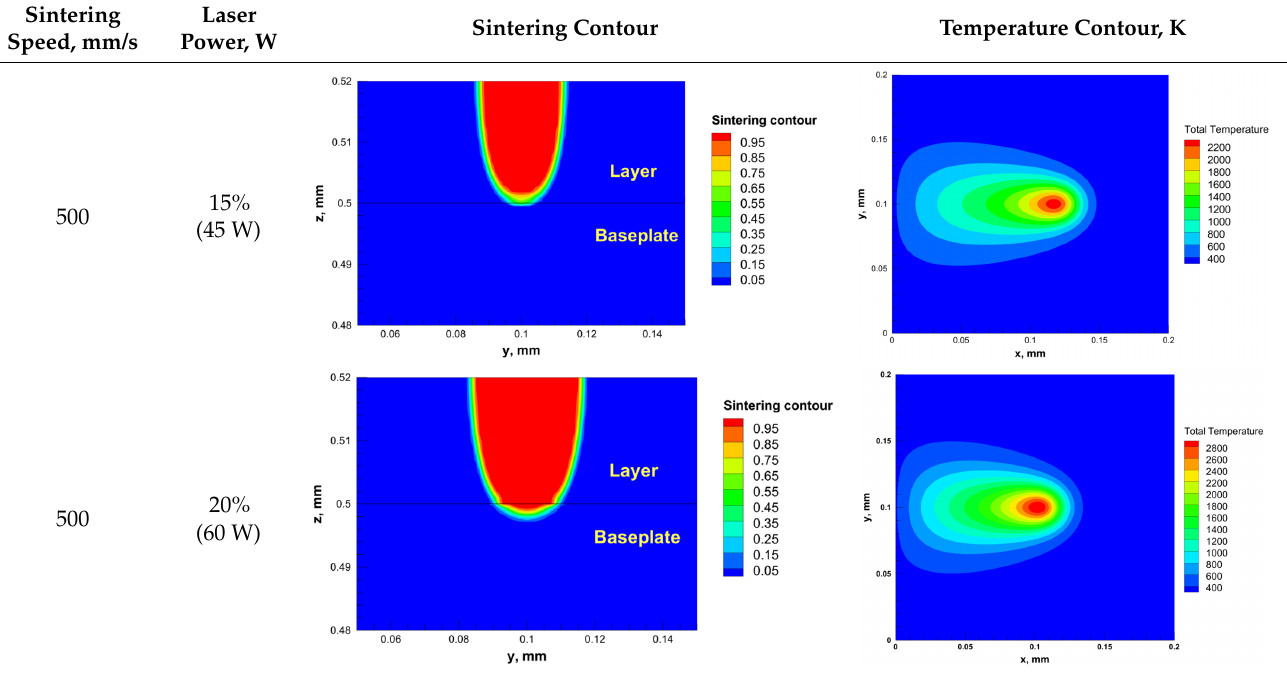
Table 3. Laser power selection for sintering speed of 500 mm/s.